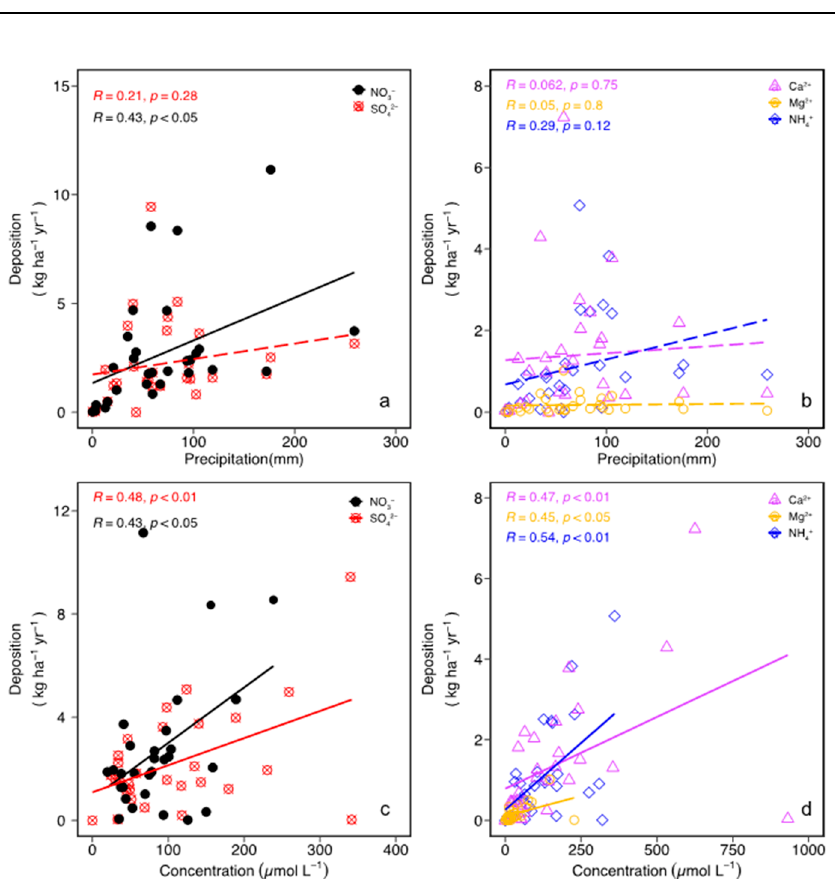
Figure 4. Correlations of monthly deposition of major ions with monthly precipitation amounts ( a , b ) and their concentrations ( c , d ) in Qingyuan throughout 2018–2020. Solid lines and dashed lines represent significant and non-significant relations, respectively.